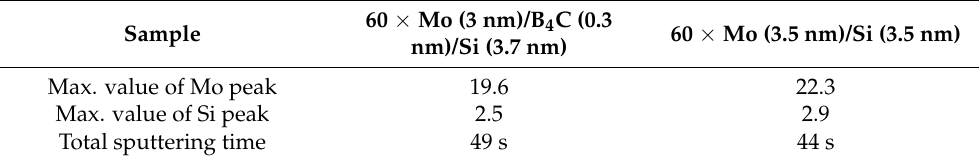
Figure 6. The measured intensity of Mo + B against the intensity of Si + C in the range of 15 and 35 s as shown in Figure 5. Note that the linear relation indicates that there is no matrix effect upon GDOES depth profiling of the Mo/B 4 C/Si multilayer. Table 2. The maximum peak value and total sputtering time of the measured GDOES depth profiles for the Mo/B 4 C/Si and Mo/Si multilayer